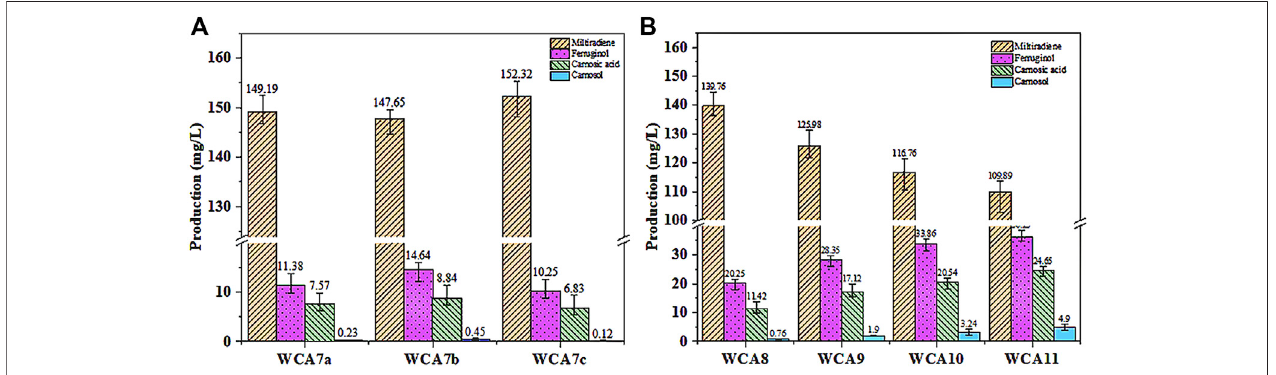
FIGURE6| CAproductionin S.cerevisiae increasedinastepwisemanner. (A) EffectoftheoverexpressionofScCTA1andScCTT1 catalasesontheproduct titer. (B) FermentationwasconductedinYPDmedium.WCA8, INO2 geneoverexpressed;WCA9, HEM3 geneoverexpressed;WCA10, POS5 geneoverexpressed;WCA11, HAC1 gene overexpressed. The data are the averages of three separate